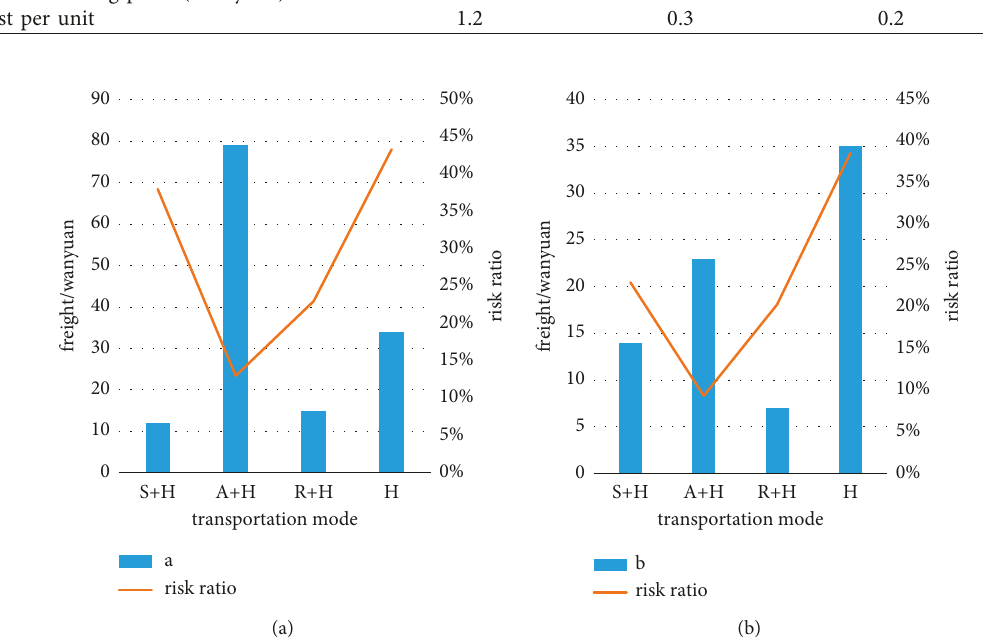
Figure 8: Freight and risk rates for a and b. (a) a demand place. (b) b demand